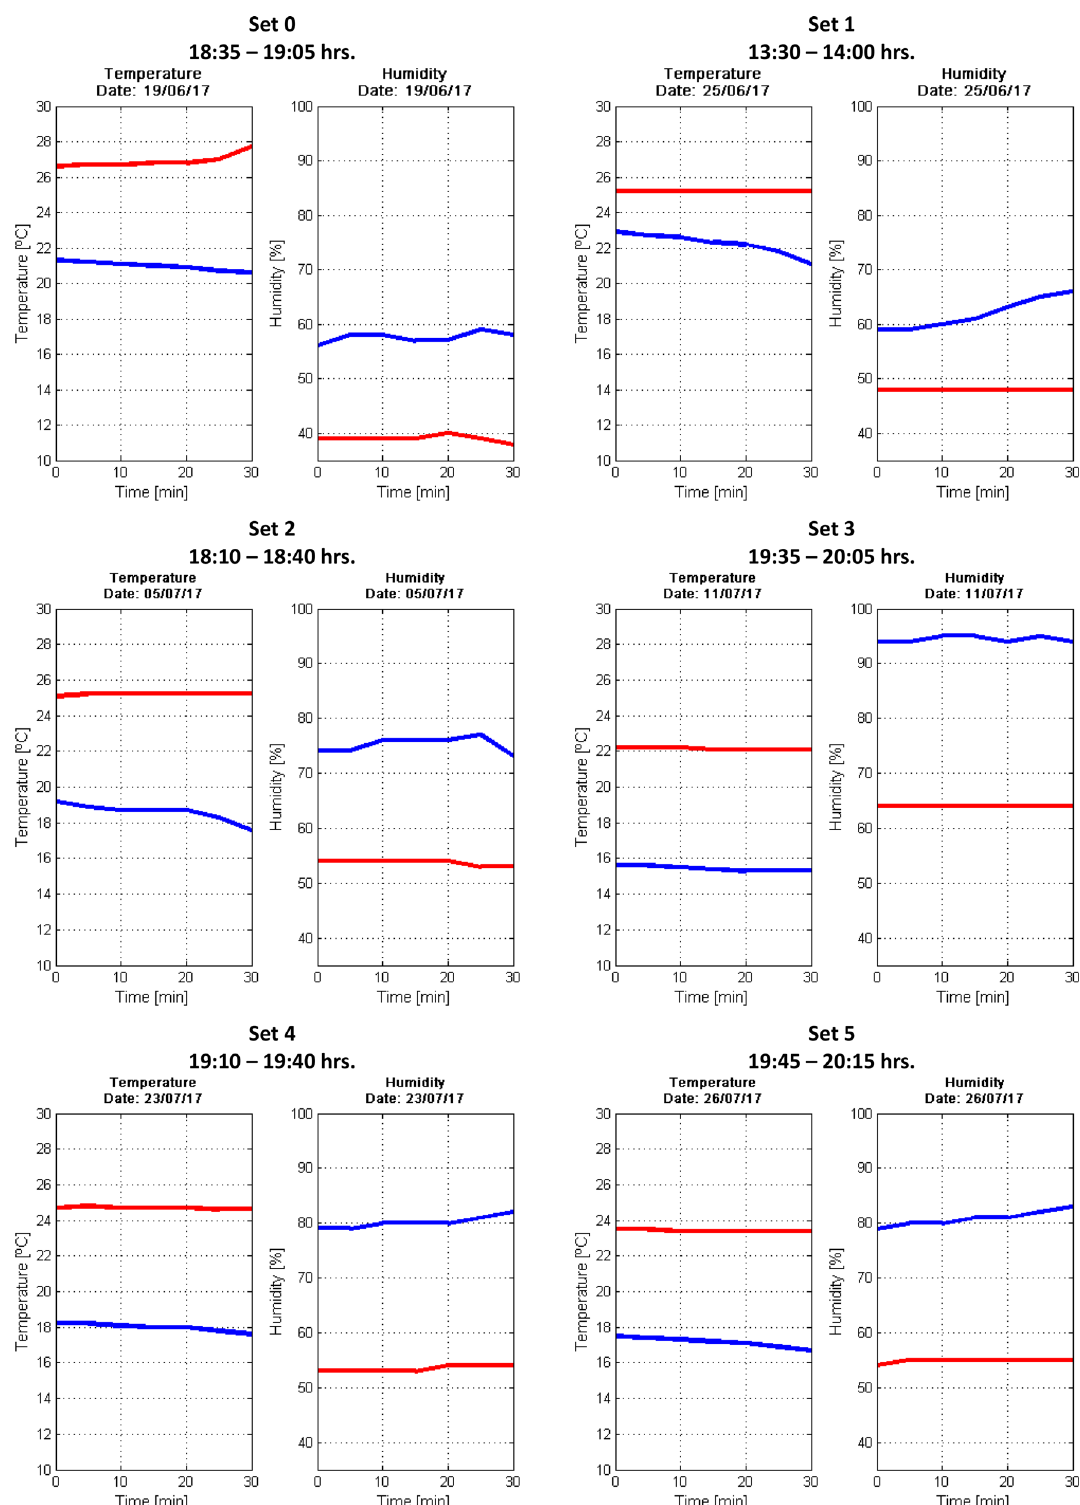
Figure 8. Temperature and humidity (external and internal) registered by the UPT weather station (Vantage Pro2, Davis Instruments Corp.) during the experimental fluorescence measurements for each cochineal